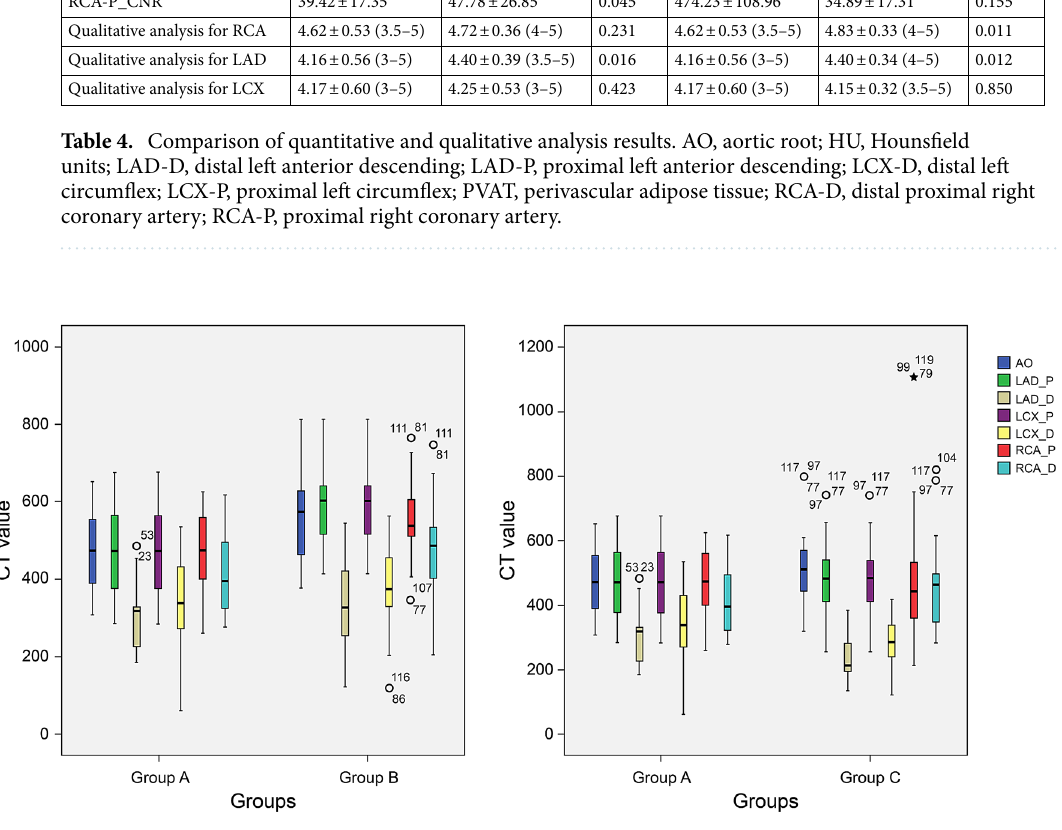
Figure 1. Comparison of CT values of all measurements in all groups. ( A ) Comparison of groups A and B. ( B ) Comparison of groups A and